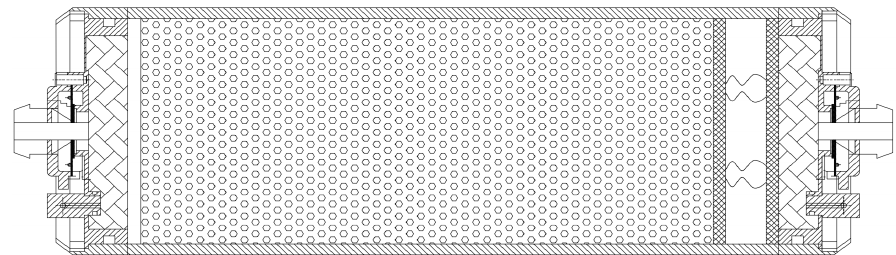
Figure 2. Molecular sieve bed structure.